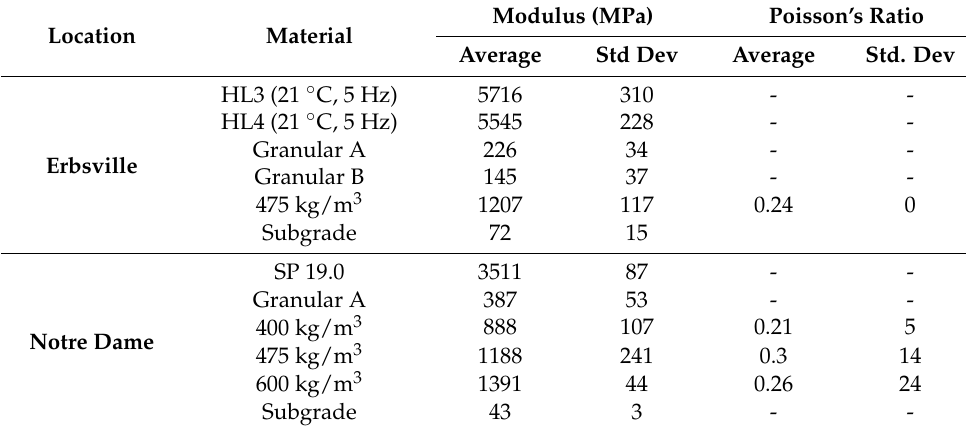
Table 1. Notre Dame Drive and Erbsville layer properties (Adopted from